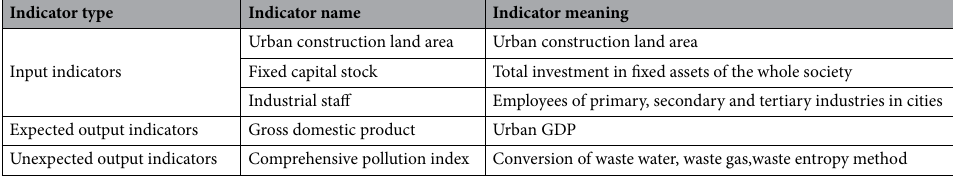
Table 1. Input–output